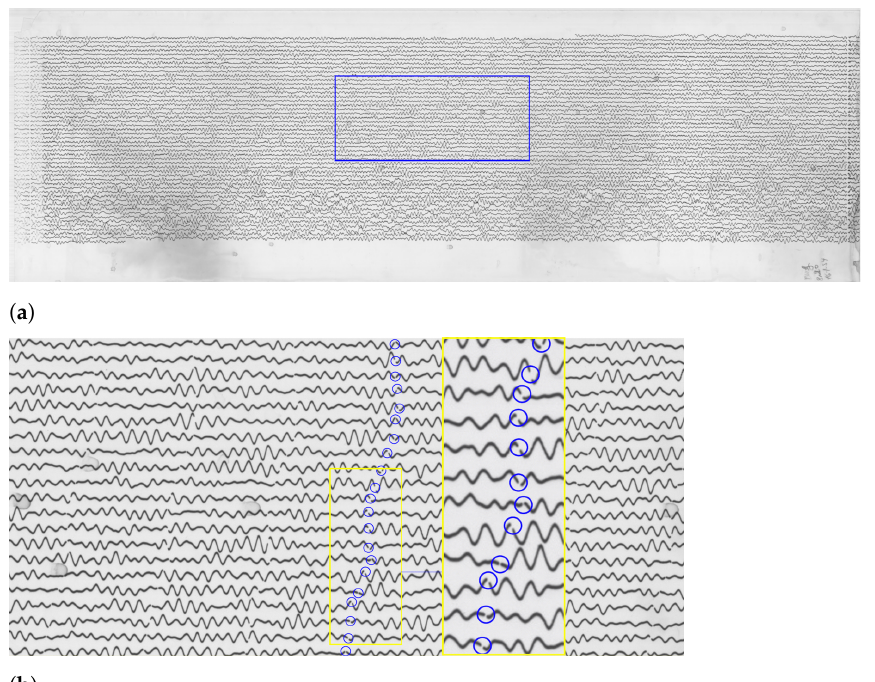
Figure 7. Analysing seismogram in paper-based format: traces and time gaps. ( a ) Original scanned seismogram (UCC19540116Gal_E_0820.tif). ( b ) Enlarged fragment of image showing time gaps which indicate minute marks and a zoomed segment separating the trace line between each other with tiny white gaps breaking the